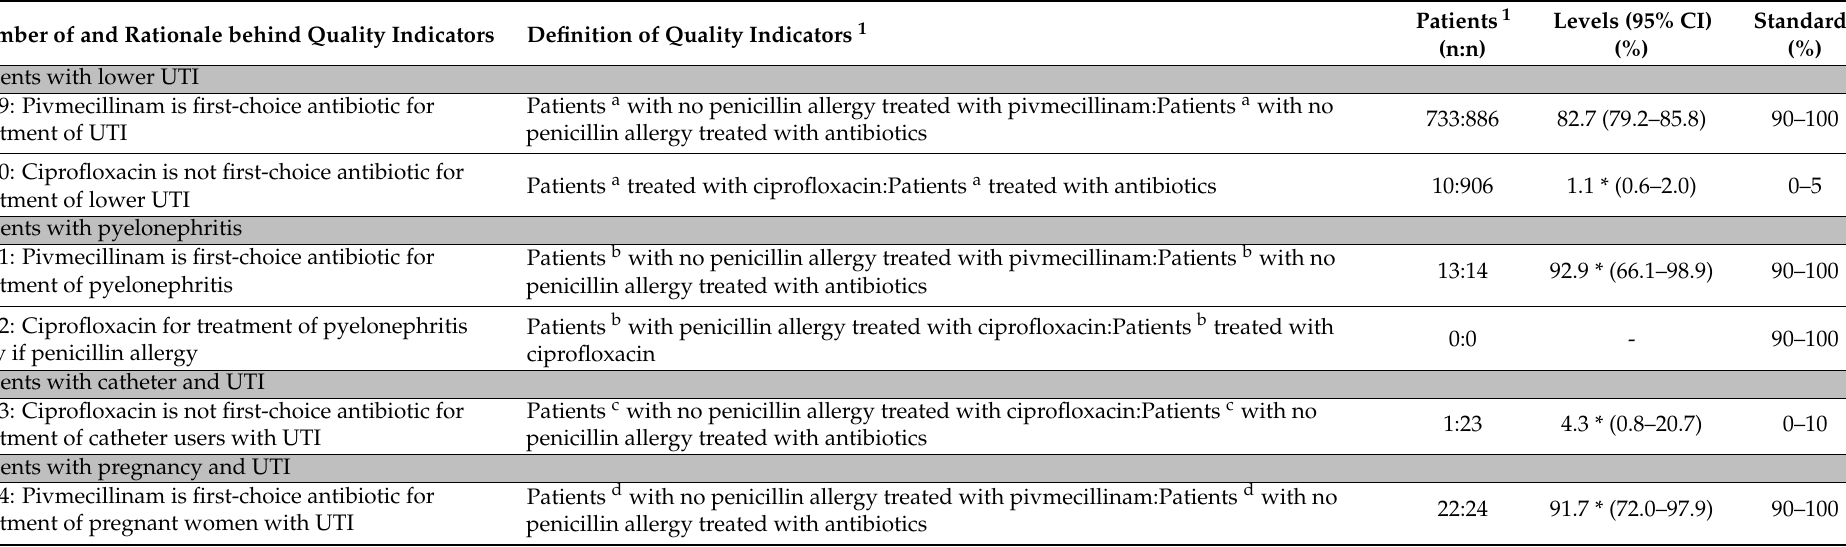
Table 3. Levels and standards for six quality indicators focusing on the choice of antibiotics prescribed for urinary tract infections in Danish general practice (2020). Number of and Rationale behind Quality